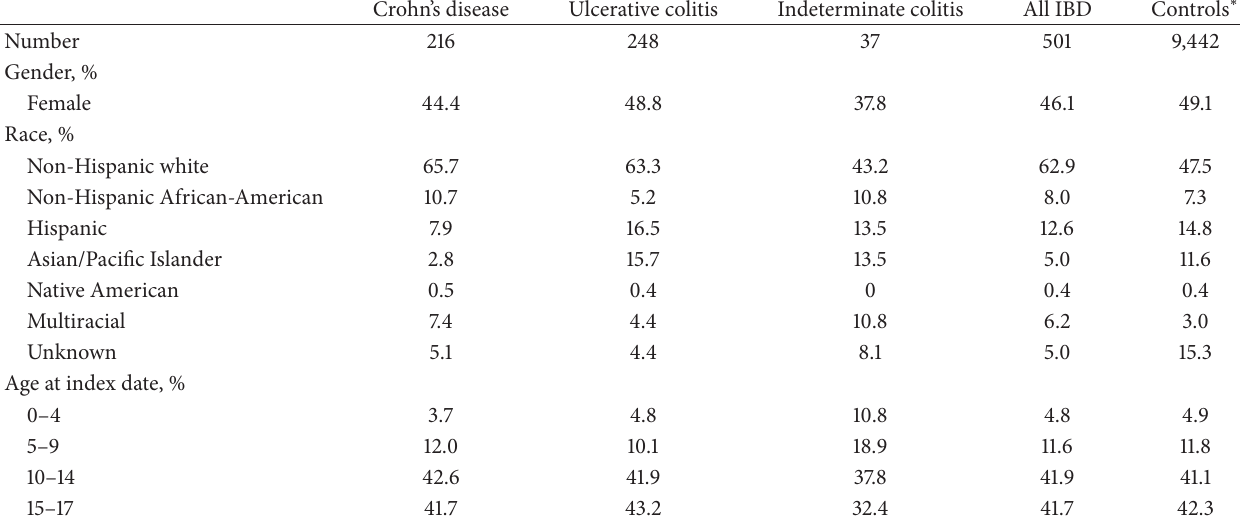
Table 1: Demographics of cases and age and membership matched controls.